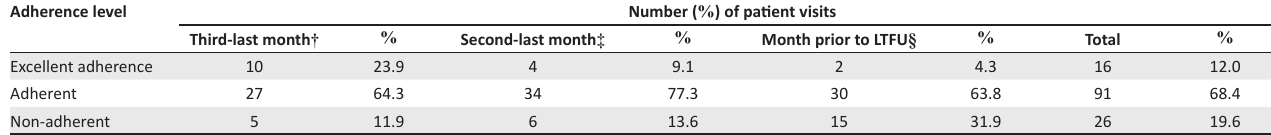
TABLE 3: Adherence patterns over the period of 3 months prior to becoming lost to follow-up. Adherence level Number ( % ) of patient visits